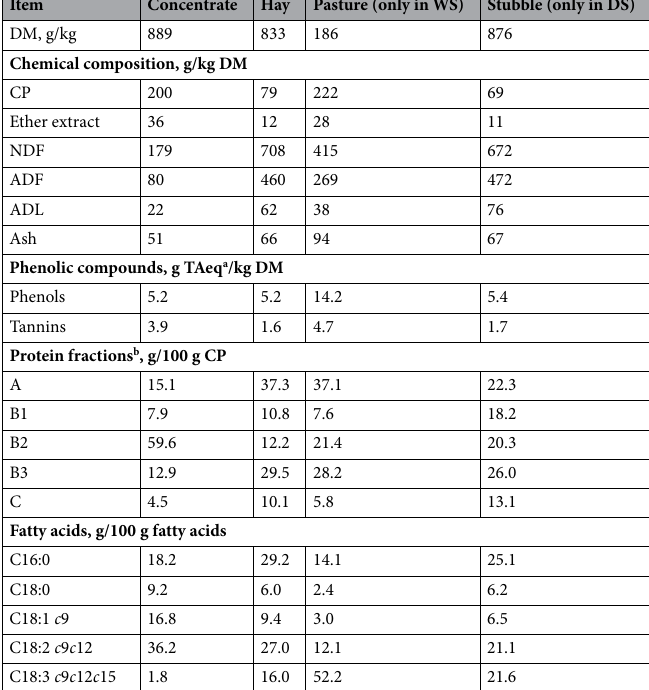
Table 1. Chemical composition of feeds used in wet season (WS) and dry season (DS) experiments. a TAeq tannic acid equivalents. b A NPN, B1 buffer-soluble true protein, B2 neutral detergent soluble protein, B3 acid detergent soluble protein, C acid detergent insoluble